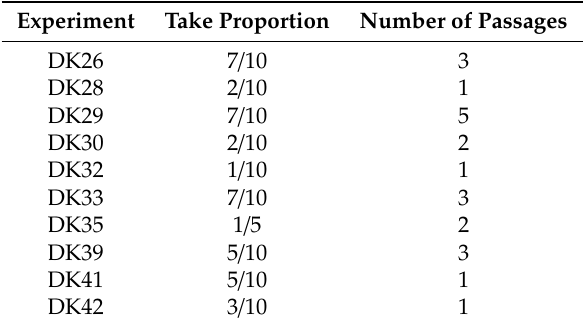
Table 2. Tumour take proportion of the primary material in the nude mice. 2